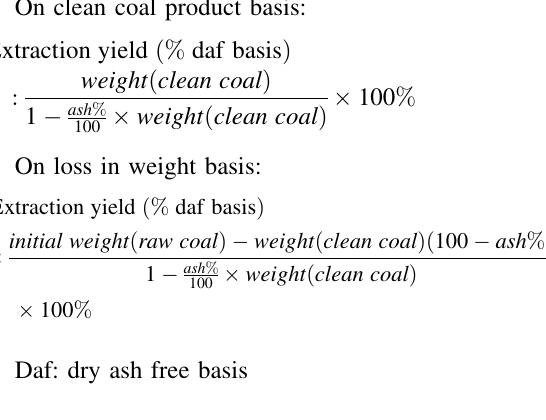
Table 1 Proximate and ultimate analysis (wt%) (on air dried basis) of Kedla coal Proximate analysis Ultimate analysis (daf) Calorific value